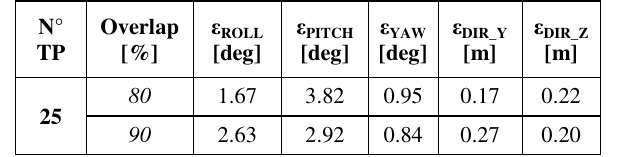
Table 7. Error propagated - 25 TP – simulation 3